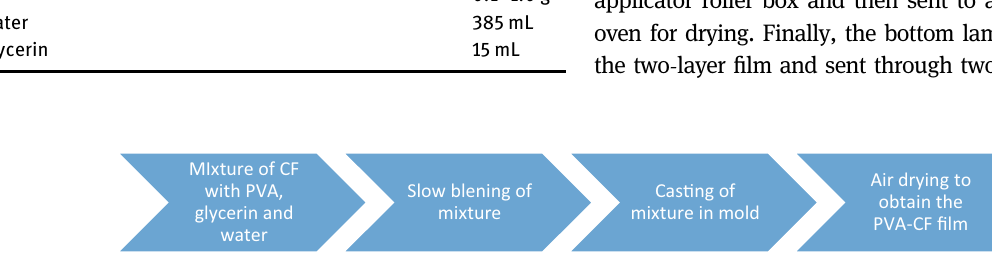
Figure 2: Process of fabricating PVA - CF transparent conductive fi